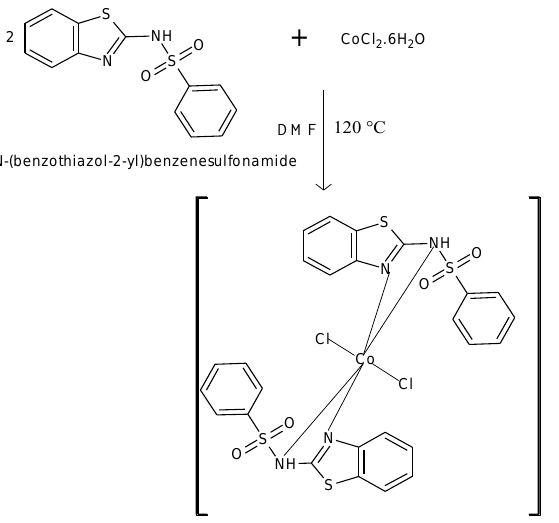
Scheme 4. Synthesis of